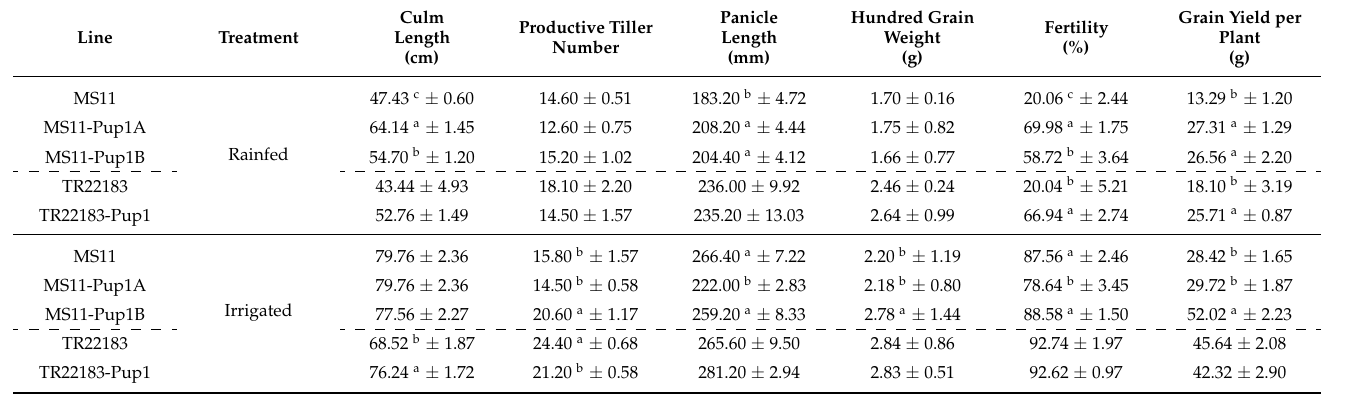
Figure 5. Yield response of temperate Pup1 introgression lines grown in P-non-supplied and P- supplied soils under rainfed conditions in 2022. ** indicates statistical significance using DMRT, whereas ns denotes insignificance within a genetic background at p = 0.05. Table 5. Reproductive stage response of temperate Pup1 introgression lines grown under rainfed and irrigated conditions (2021). Means with the same letters within a genetic background and treatment are not significantly different using DMRT at p = 0.05. Values are means ±